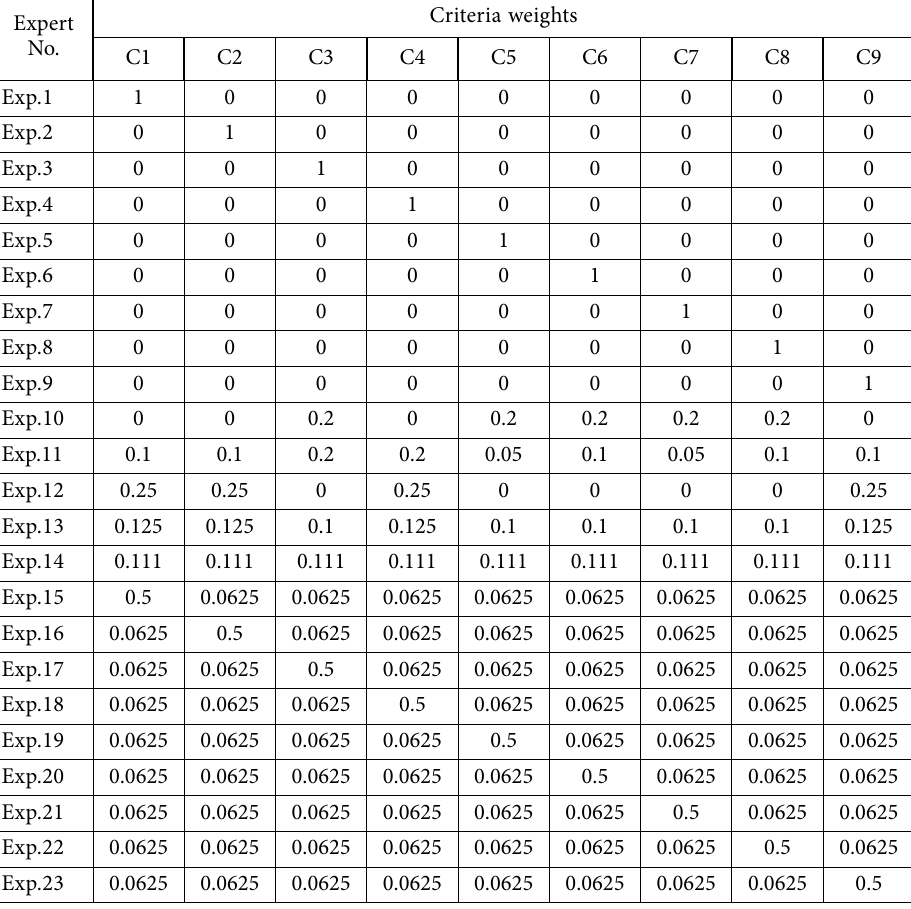
Table 6. Sensitivity analysis through different